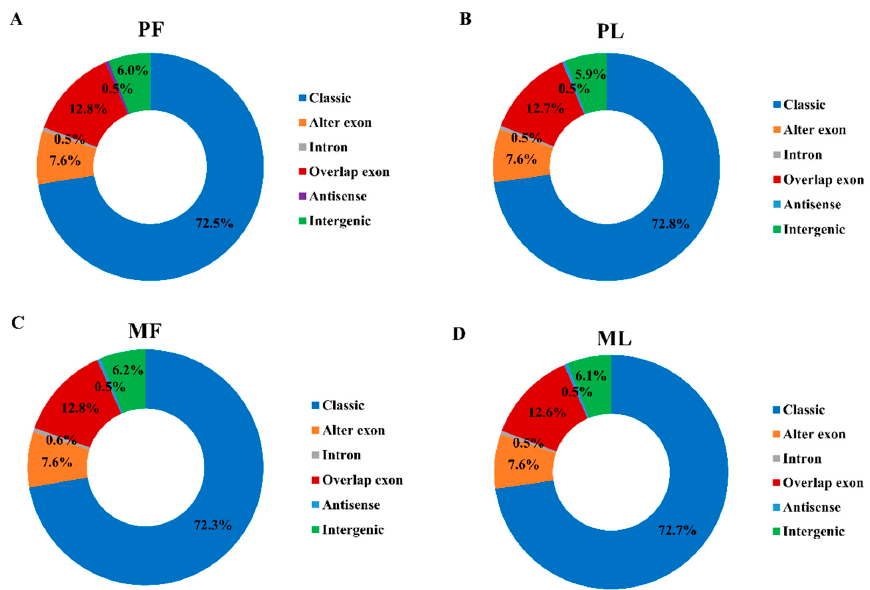
Figure 2. Types of identified circular RNAs. ( A ) The types of circular RNAs identified in polytocous sheep in the follicular phase ( B ), polytocous sheep in the luteal phase, monotocous sheep in the follicular phase (MF) ( C ), and monotocous sheep in the luteal phase (ML) ( D ).